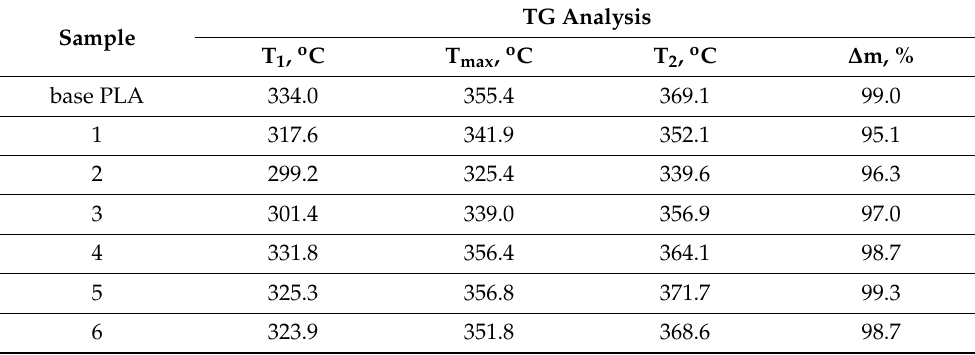
Figure 13. TG curves. Table 3. TG analysis parameters of base and plasticized